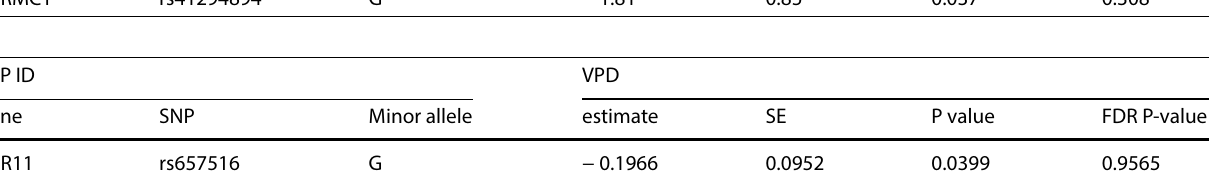
* Estimate: linear regression coefficient